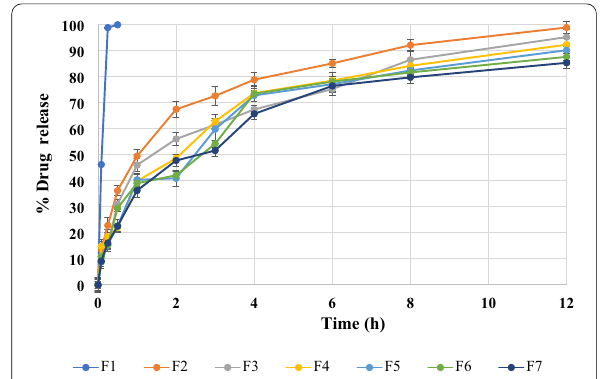
Fig. 7 Cumulative Drug Release (%) of Pirfenidone Nanoparticles * F1 Pure drug PFD 10 =